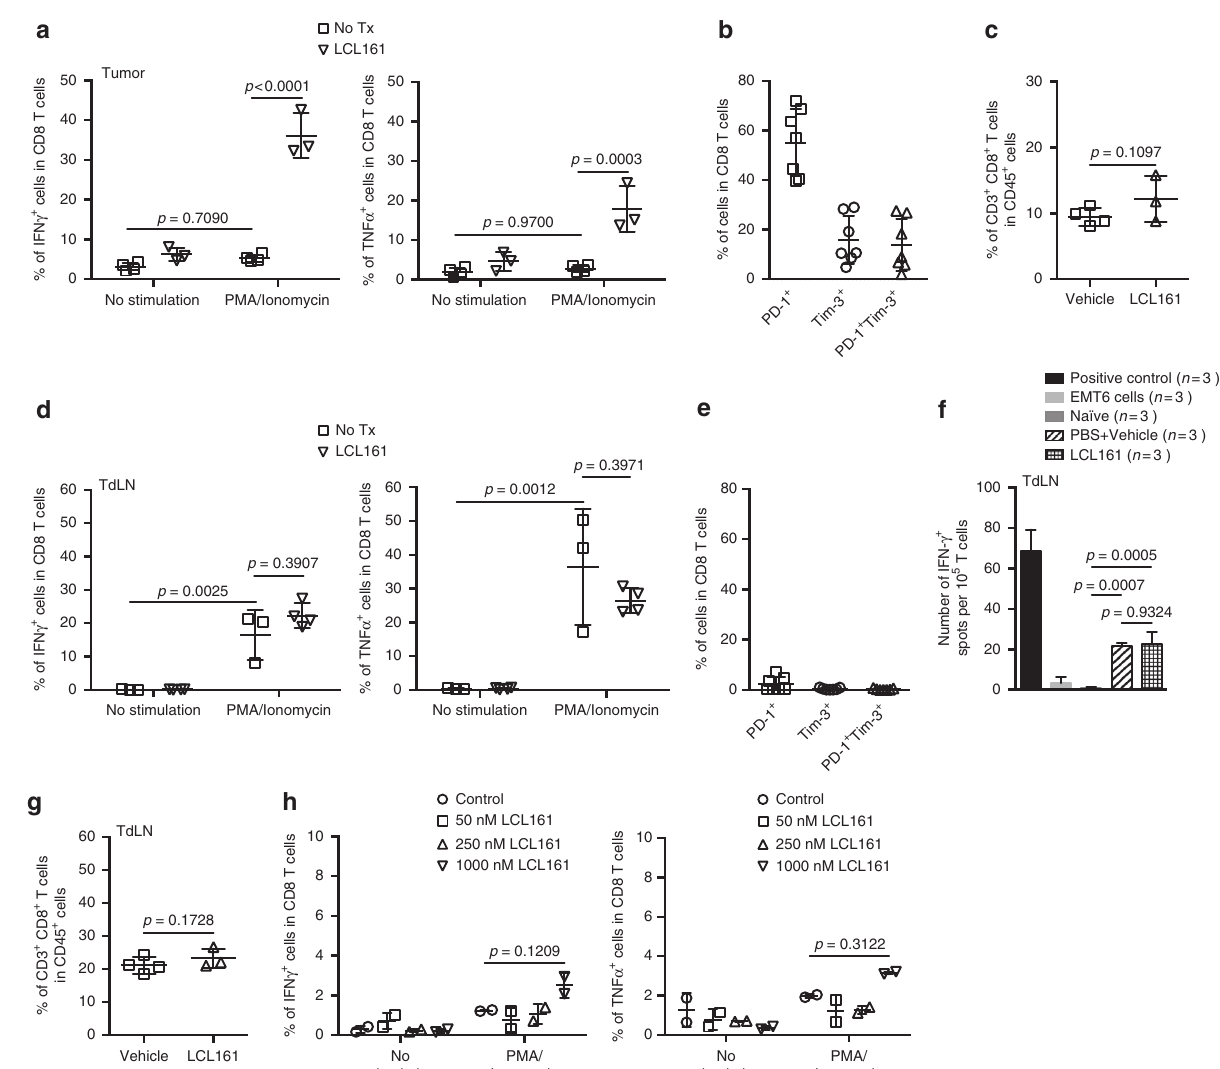
Fig. 2 LCL161 therapy rescues CD8 + T-cell exhaustion within the TME. a Intracellular staining for IFN γ or TNF α within CD8 + T cells isolated from EMT6 tumors 7 days post treatment and stimulated with PMA and ionomycin ex vivo, measured by fl ow cytometry (duplicate experiments; mean ± SD; ANOVA with Bonferroni ’ s multiple comparisons test). b Membrane staining for PD-1 and Tim-3 expression on CD8 + T cells isolated from 12-day-old EMT6 tumors, measured by fl ow cytometry (duplicate experiments; mean ± SD). c CD8 + T cells within EMT6 tumors 7 days post treatment, measured by fl ow cytometry (triplicate experiments; mean ± SD; t -test). d Intracellular staining for IFN γ or TNF α within CD8 + T cells isolated from EMT6 TdLN 7 days post treatment and stimulated with PMA and ionomycin, measured by fl ow cytometry (single experiment; mean ± SD; ANOVA with Bonferroni ’ s multiple comparisons test). e Membrane staining for PD-1 and Tim-3 expression on CD8 + T cells isolated from 12-day-old EMT6 TdLNs, measured by fl ow cytometry (duplicate experiment; mean ± SD). f Activation of CD8 + T cells isolated from TdLN 8 days post treatment, after co-culture with EMT6 cells, measured by IFN γ ELISpot assay ( n = 3 biological replicates, single experiment; mean ± SD; ANOVA with Tukey ’ s multiple comparisons test). g CD8 + T cells within EMT6 TdLN 7 days post treatment, measured by fl ow cytometry (duplicate experiments; mean ± SD; t -test). h Intracellular staining for IFN γ or TNF α within CD8 + T cells isolated from 12-day-old EMT6 tumors and treated in vitro with LCL161 at the indicated concentrations